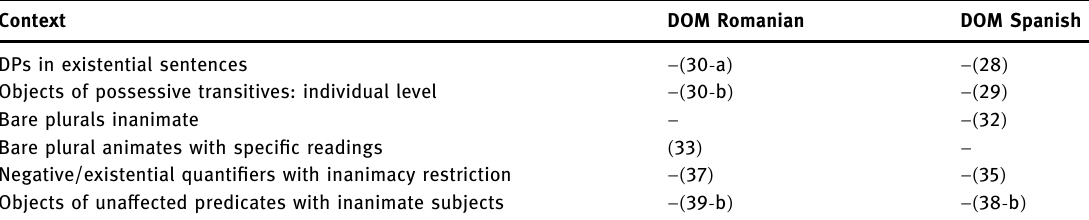
Table 4: Ungrammatical DOM – Romanian and standard Spanish